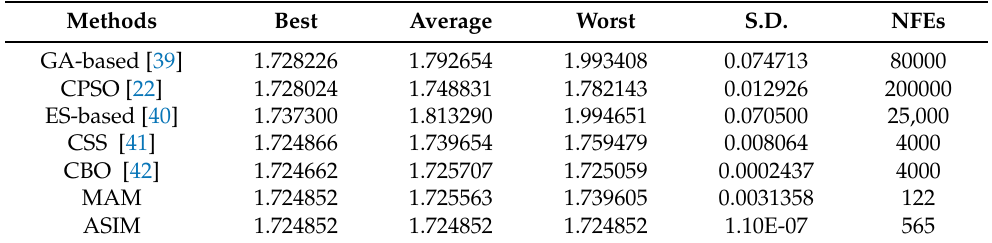
Table 4. Statistical results from different optimization methods for the welded beam design problem.